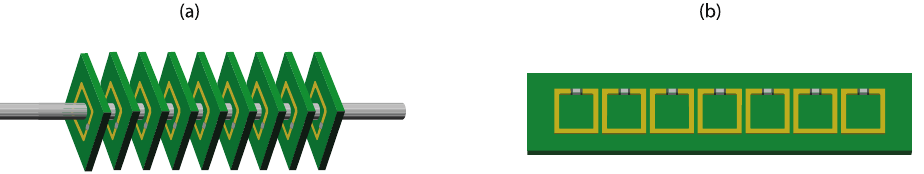
Figure 1. Axial ( a ) and planar ( b ) metamaterial arrays resulting in forward ( a ) and backward ( b ) MI waves